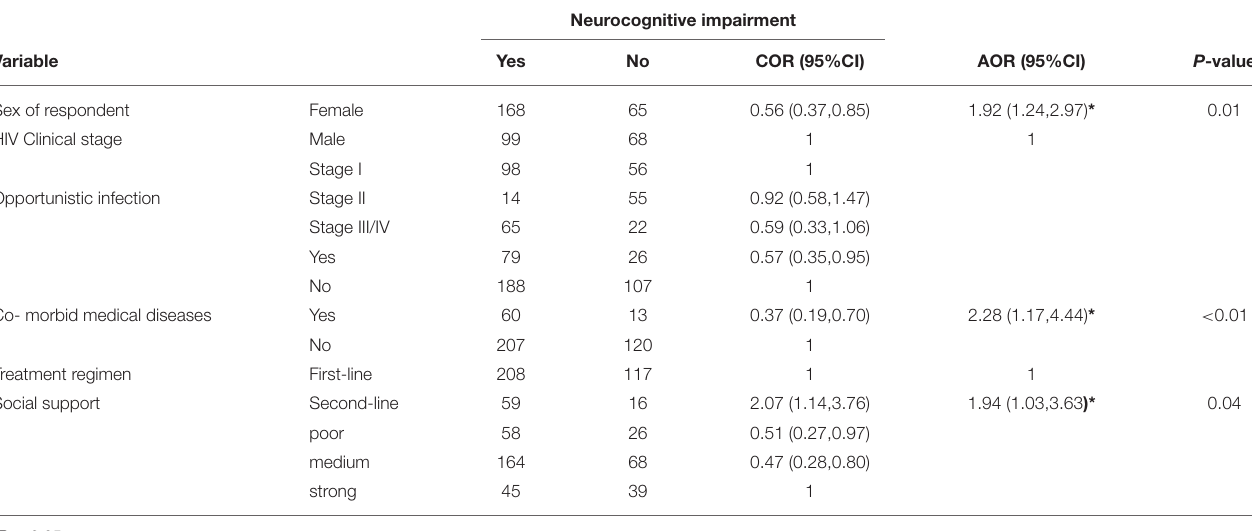
TABLE 4 | Bivariate and multivariate analysis of variables associated with NCI among PLH attending at public health institution in Bahir Dar, Ethiopia, 2016 ( n = 400).